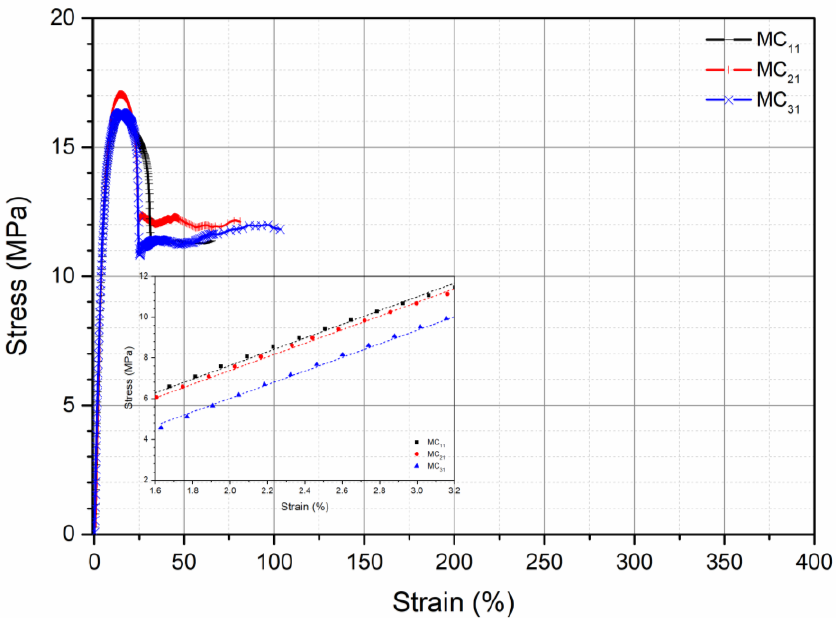
Figure 2. Stress–strain curve of samples coming from pellets conditioned under the three conditions Figure 2. Stress – strain curve of samples coming from pellets conditioned under the three condi- and specimens for mechanical testing conditioned at RH = tions and specimens for mechanical testing conditioned at RH = 0%.